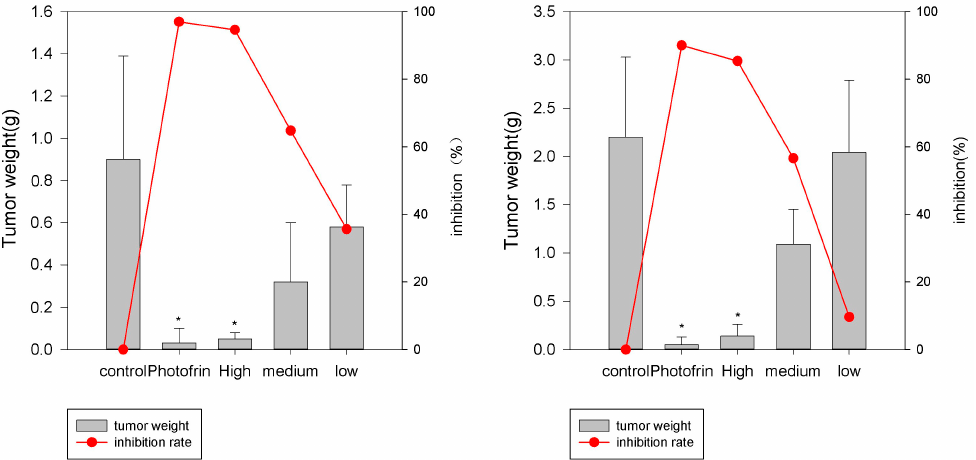
Figure 4. Tumor weights in esophagus tumor CaEs-17 xenografts. First experiment ( left ); second experiment ( right ). Control (0.9% NaCl), Photofrin (20 mg/kg); Sinoporphyrin sodium concentration: high dose groups (2 mg/kg), medium dose groups (1 mg/kg), and low dose groups (0.5 mg/kg). * p < 0.05, when compared with control groups.